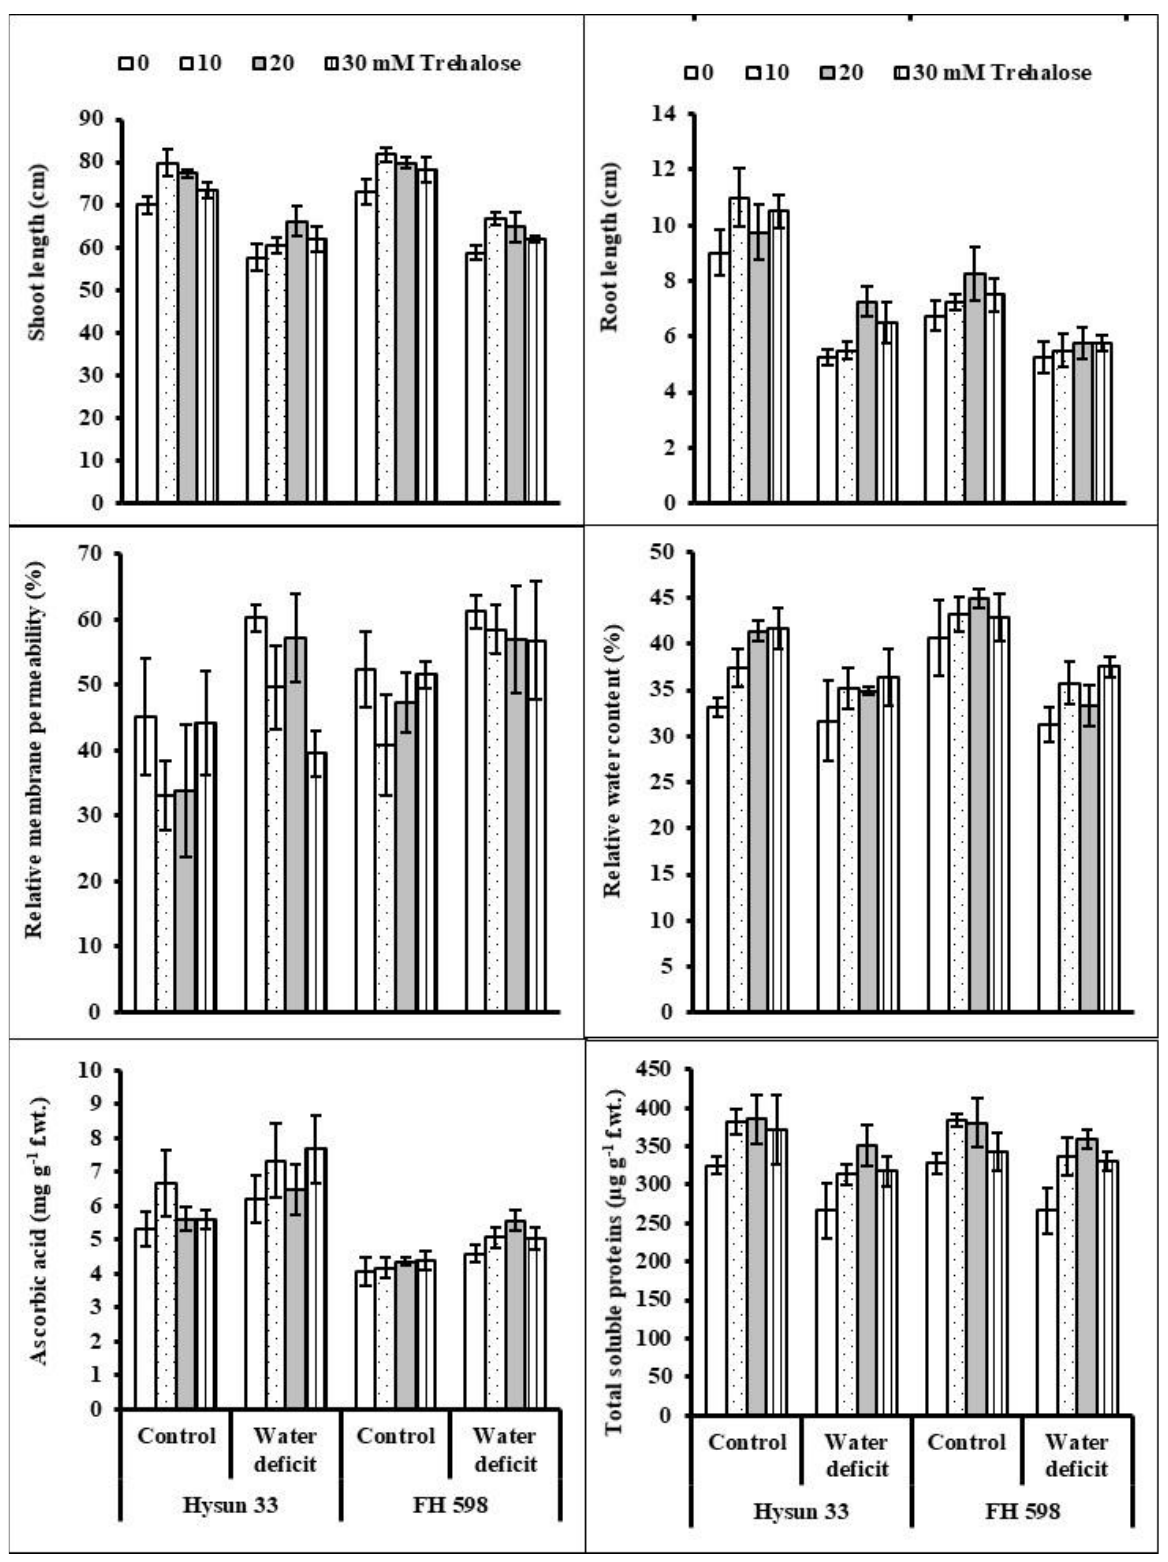
Figure 1. Shoot length, root length, relative membrane permeability, relative water content, ascorbic acid, and total soluble proteins of two drought-stressed and non-stressed cultivars of sunflower ( Helianthus annuus L.) plants subjected to varying levels of foliar-applied trehalose (mean ± S.E.).